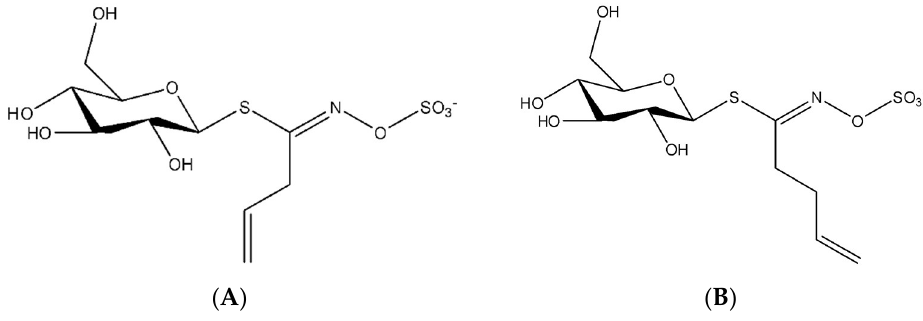
Figure 1. Chemical structure of ( A ) sinigrin and ( B ) gluconapin.